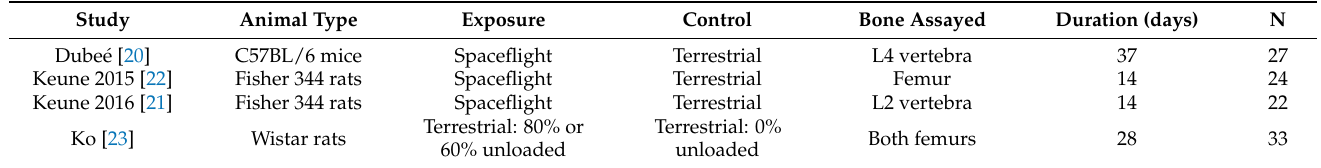
Table 1. Study design